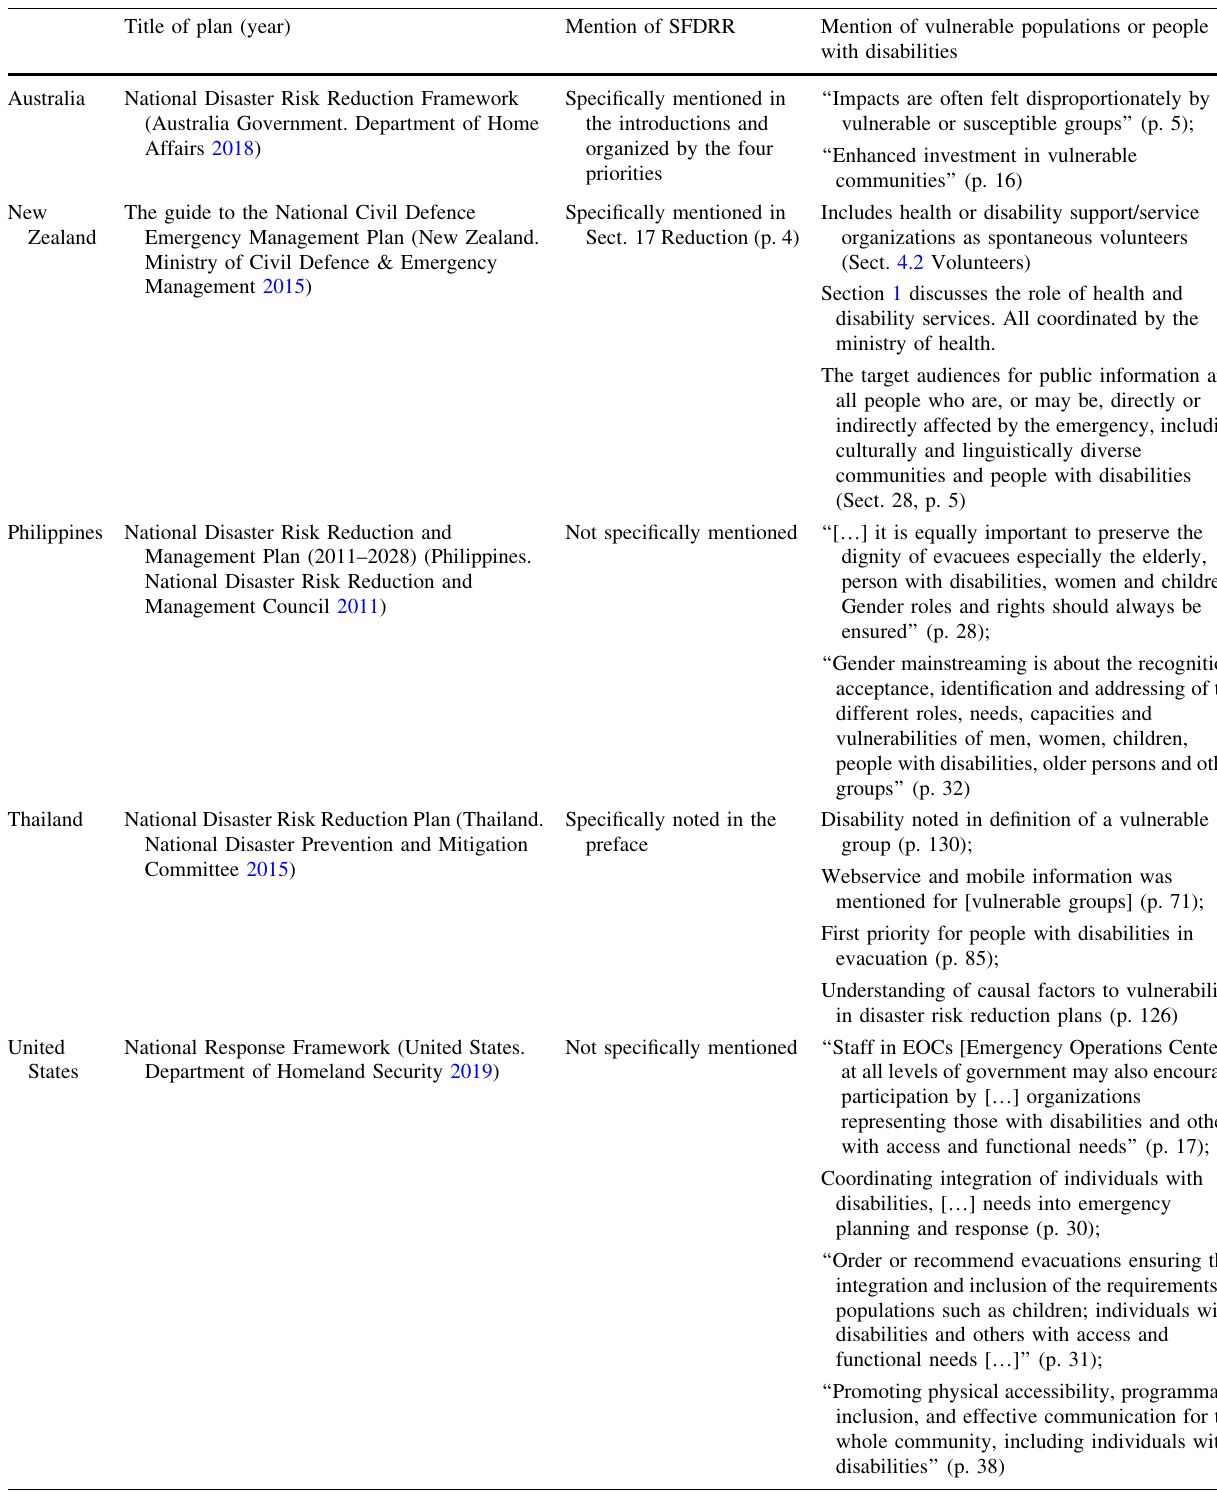
Table 1 Quick review of national level disaster plans in six countries Title of plan